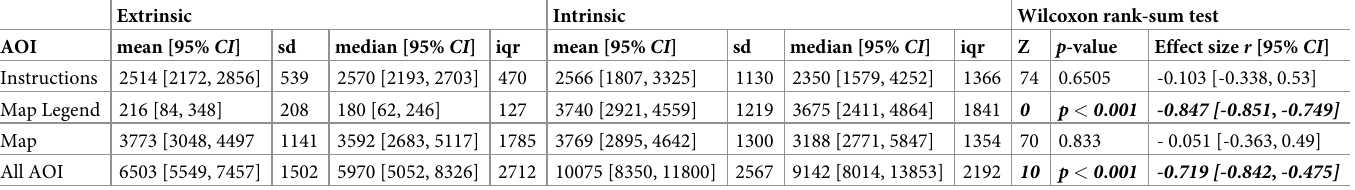
Table 2. Summary of AOI dwell times